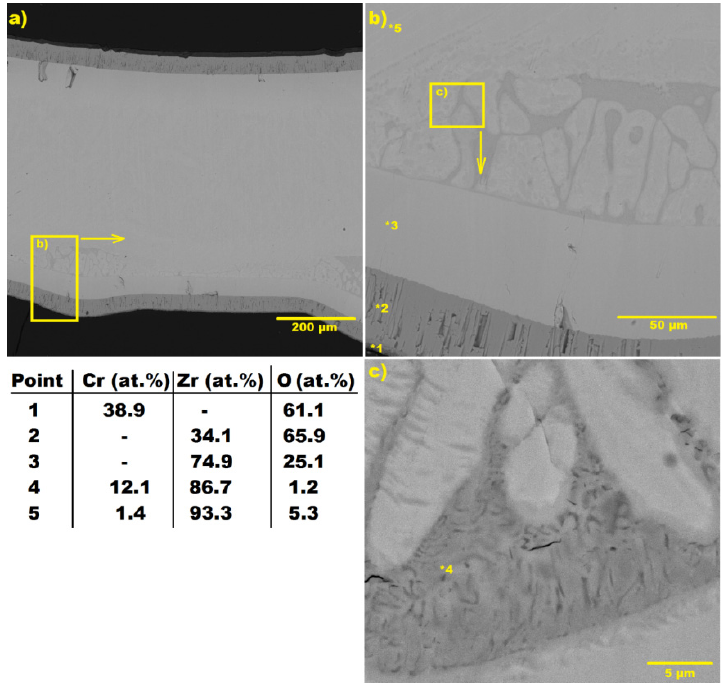
12 of 17 Figure 12. Optical images of the cross-section microstructure of the ZrO 2 /Cr-100 ( a – d ) and ZrO 2 /Cr ( e – h ) samples after steam oxidation at 1250 °C (120 and 300 s), 1330 °C (120 s), and 1400 °C (120 s), respectively. The cross-section microstructure of both samples after oxidation in a water steam at 1250 °C was the same as it was after oxidation tests at 1200 °C (Figure 7). According to the optical images with high magnification, the Cr 2 O 3 oxide layer was formed on the outer surface; below, a layer of residual Cr with a lot of cavities was found at the region of coating/alloy interface. Moreover, the sample with the thinnest ZrO 2 /Cr multilayers had a higher number of blisters than that of the sample with the single-layer ZrO 2 barrier. The same effect was obtained in the steam oxidation tests performed at 1200 °C. At a higher temperature of the steam oxidation tests (1330 and 1400 °C), the cross- section microstructure of the samples changed significantly. Based on the SEM and EDS data (Figure 13), the outer layer was composed of Cr (38.9 at.%) and O (61.1 at.%), which indicates the formation of a Cr 2 O 3 scale on the sample surface. Underneath, the residual Cr layer was observed, which seems as to be a thin metallic line in the cross-section optical images on the example in Figure 12c. Below it, a layer with Zr (34.1 at.%) and O (65.9 at.%) content was found; this layer has a dark-gray color in the optical images. Then, the white layer with a low oxygen (25.1 at.%) content was observed, which corresponds to the α –